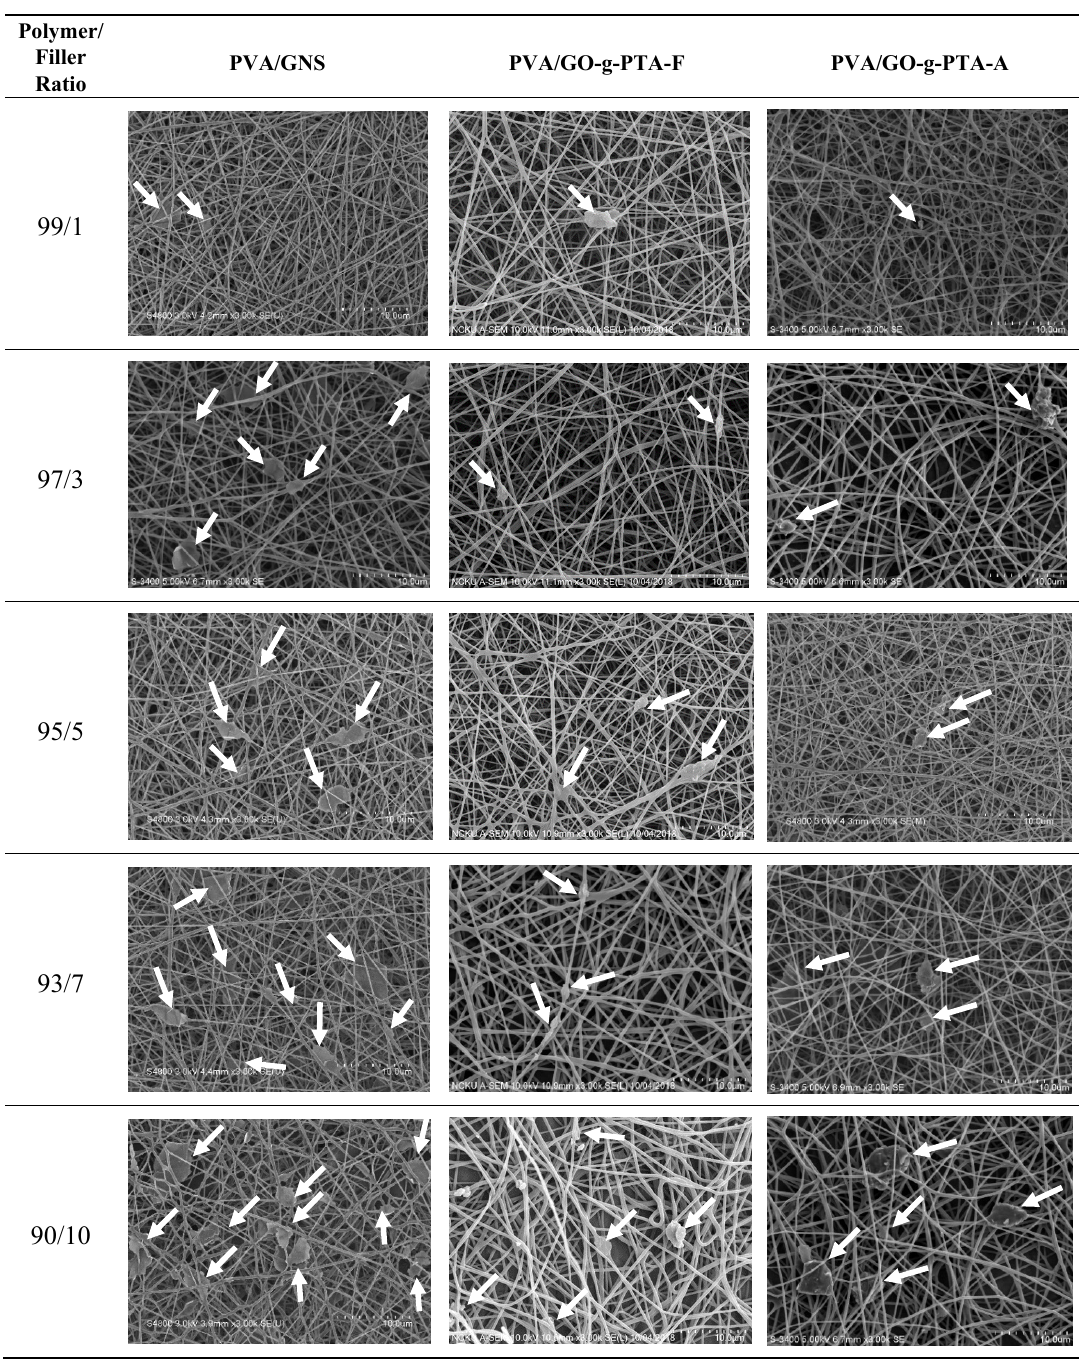
Figure 6. SEM images of electrospun PVA composite nanofibers filled with various amounts of GO, GO-g-PTA-F, and GO-g-PTA-A. The positions of GNS, GO-g-PTA-F, and GO-g-PTA-A are indicated by arrows.